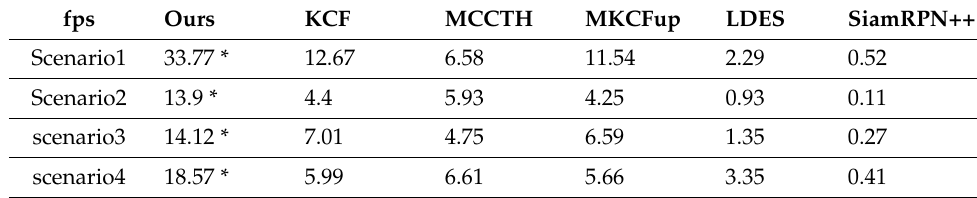
Table 6. The running time of the algorithms by using Intel I5 8250U, 3.4